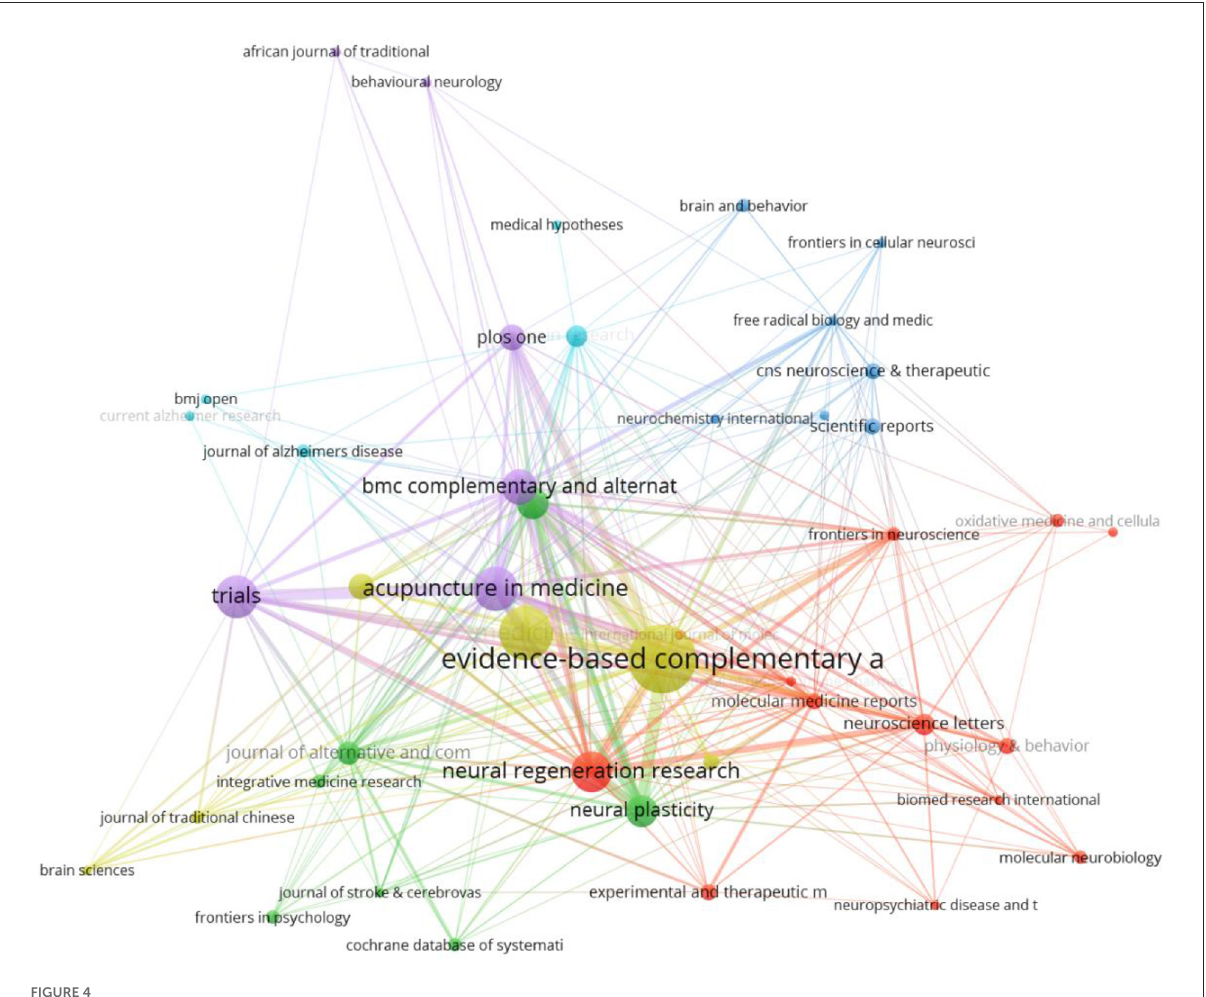
FIGURE4 Network map of cited